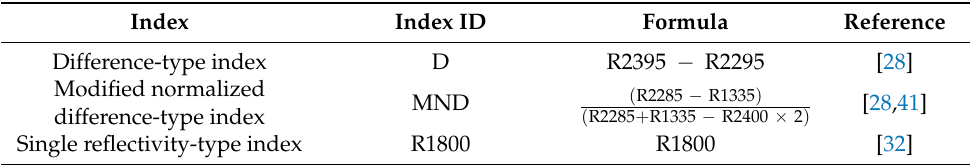
Table 3. Spectral indices constructing the second 3D matrix.